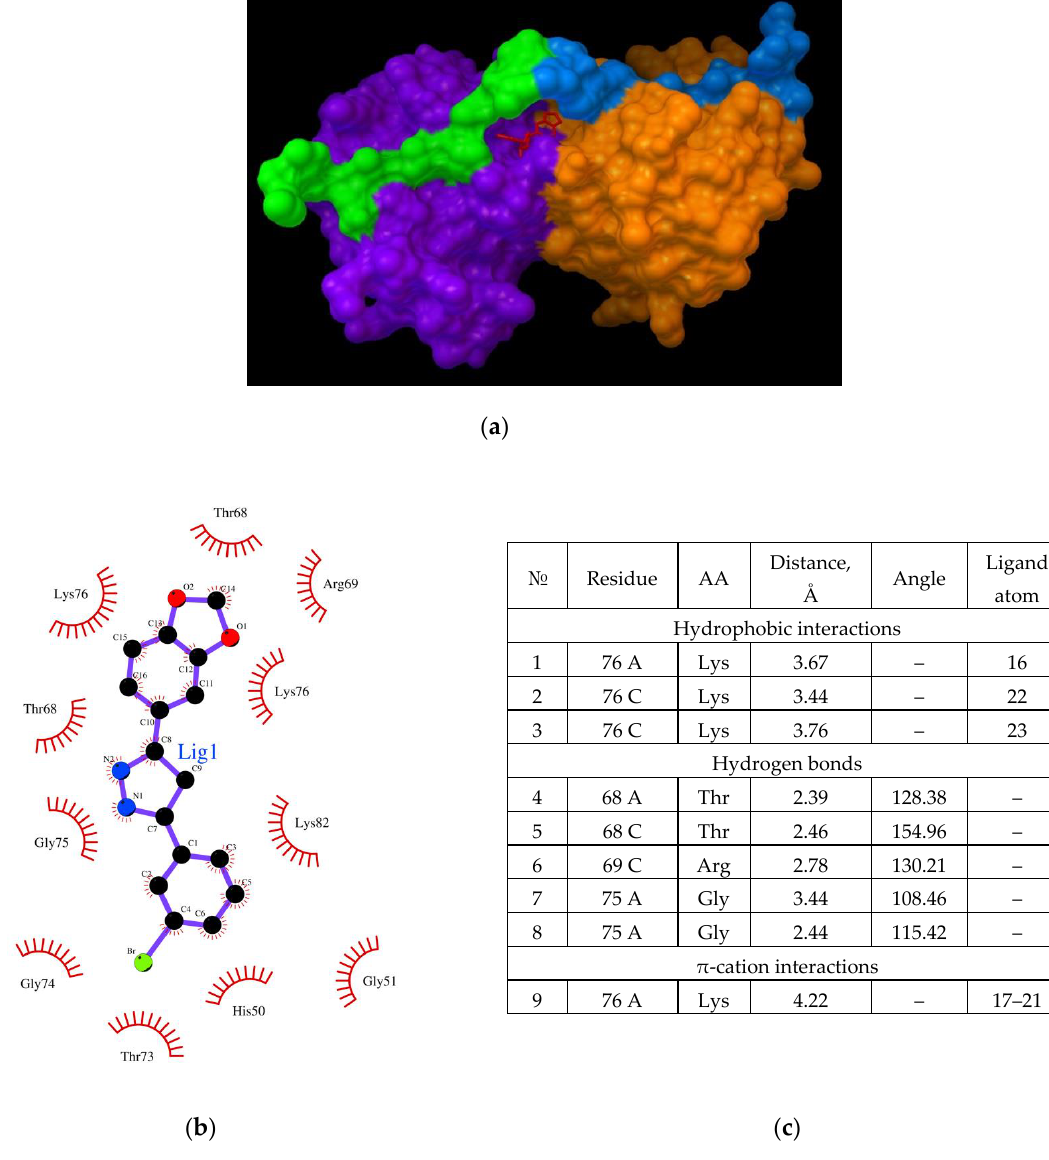
Figure 6. ( a ) Binding of the Anle138b molecule to the dimer of the CypA complex (PDB ID 6I42). CypA subunits are shown in purple and orange, the AαSyn fragment is shown in green and blue, the ligand structure is shown in red; ( b ) chart of interactions upon binding of Anle138b to the dimer of the CypA and AαSyn complex; ( c ) interactions diagram of Anle138b binding with CypA dimer.